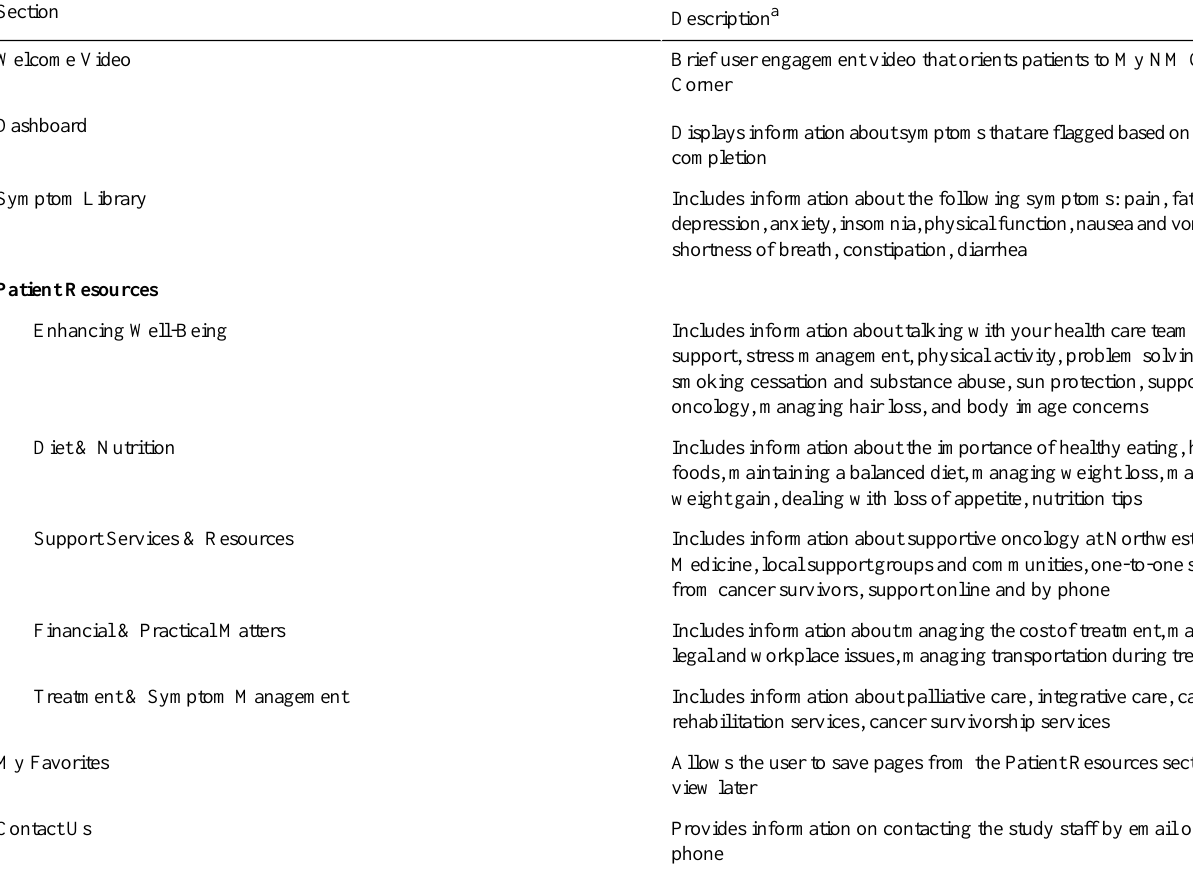
Table 1. Features of My NM Care